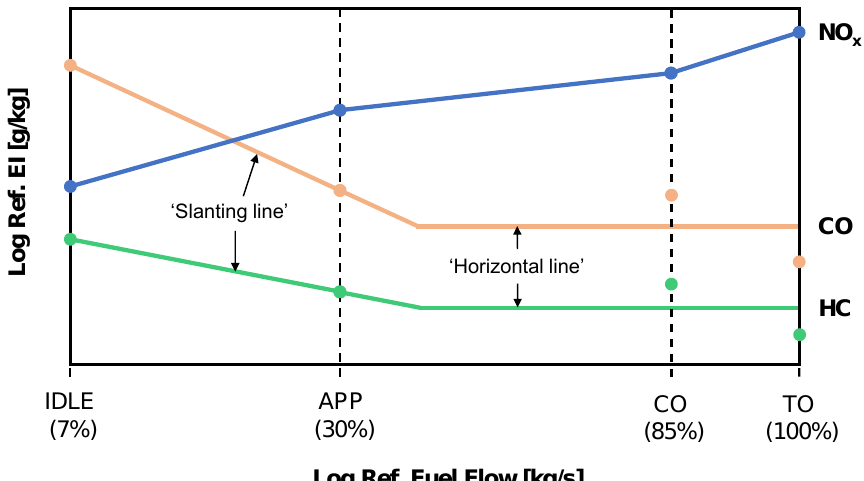
Figure 1. Example log-log plots of EI against fuel flow at reference conditions, as prescribed by the BFFM2. Percentage values refer to thrust as a percentage of maximum thrust at SLS conditions for idle (IDLE), approach (APP), climb out (CO) and take-off (TO)